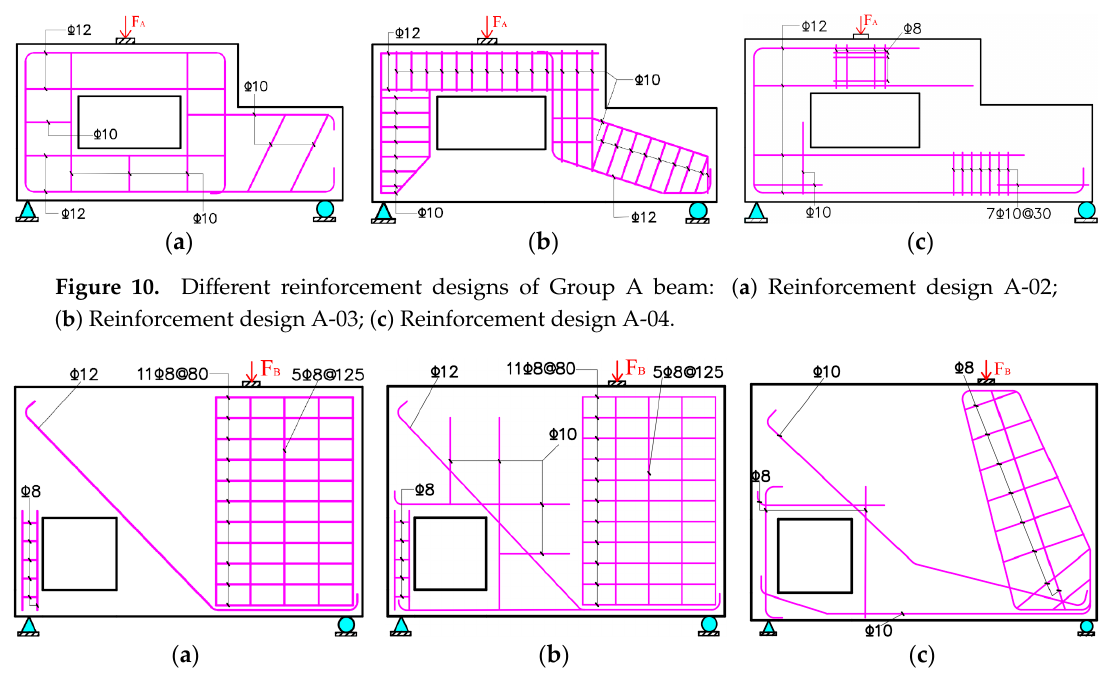
Figure 11. Di ff erent reinforcement designs of Group B beam: ( a ) Reinforcement design B-02; Figure 11. Different reinforcement designs of Group B beam: ( a ) Reinforcement design B-02; ( b ) Figure 11. Different reinforcement designs of Group B beam: ( a ) Reinforcement design B-02; ( b ) Figure 11. Different reinforcement designs of Group B beam: ( a ) Reinforcement design B-02; ( b ) ( b ) Reinforcement design B-03; ( c ) Reinforcement design Reinforcement design B-03; ( c ) Reinforcement design B-04. Reinforcement design B-03; ( c ) Reinforcement design B-04. Reinforcement design B-03; ( c ) Reinforcement design B-04.